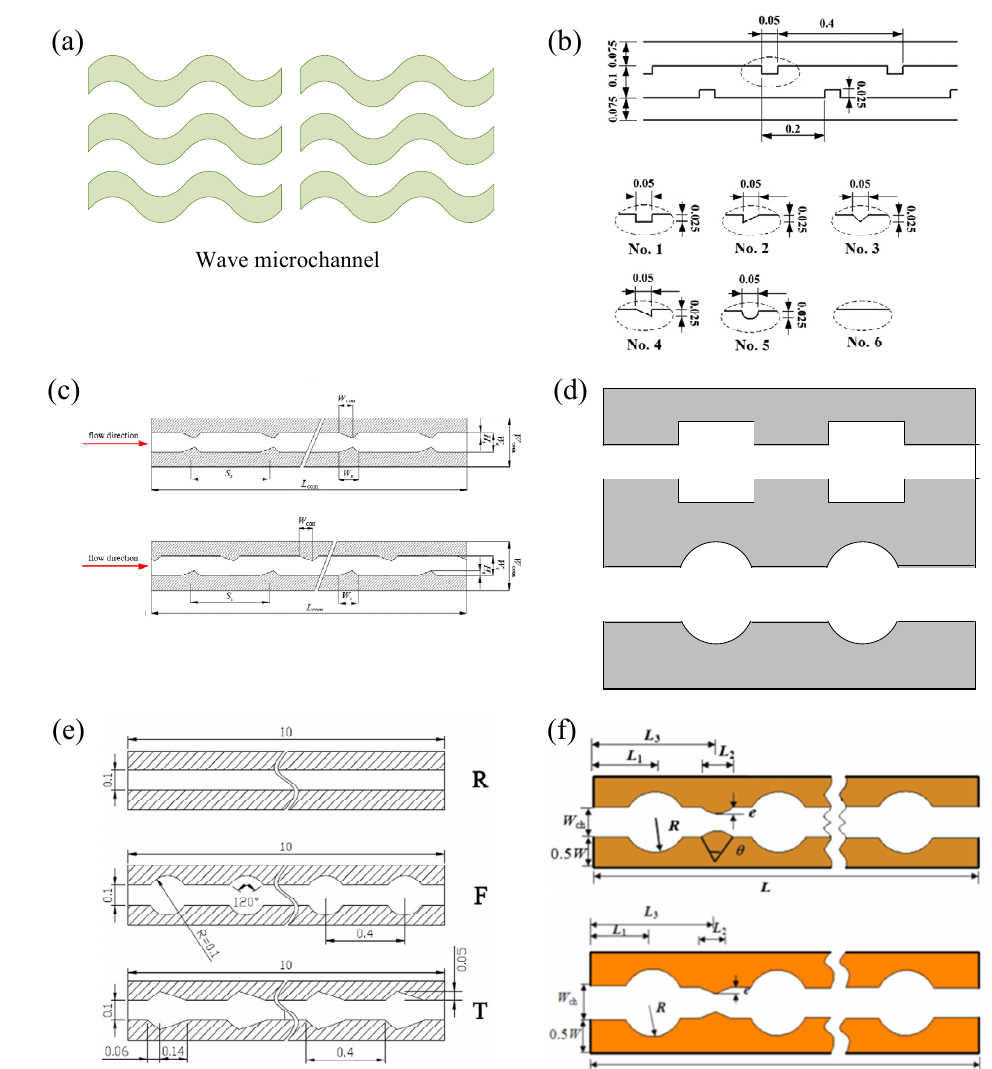
Figure 6. Schematic diagram of various geometry on the sidewall of microchannels: ( a ) Lin et al. [33], ( b ) Chai et al. (adapted from Ref. [28]), ( c ) Chai et al. (adapted from Refs. [29,30]), ( d ) Kumar [31], ( e ) Chai et al. (adapted from Ref. [77]), ( f ) Zhai et al. (adapted from Ref. [38]).